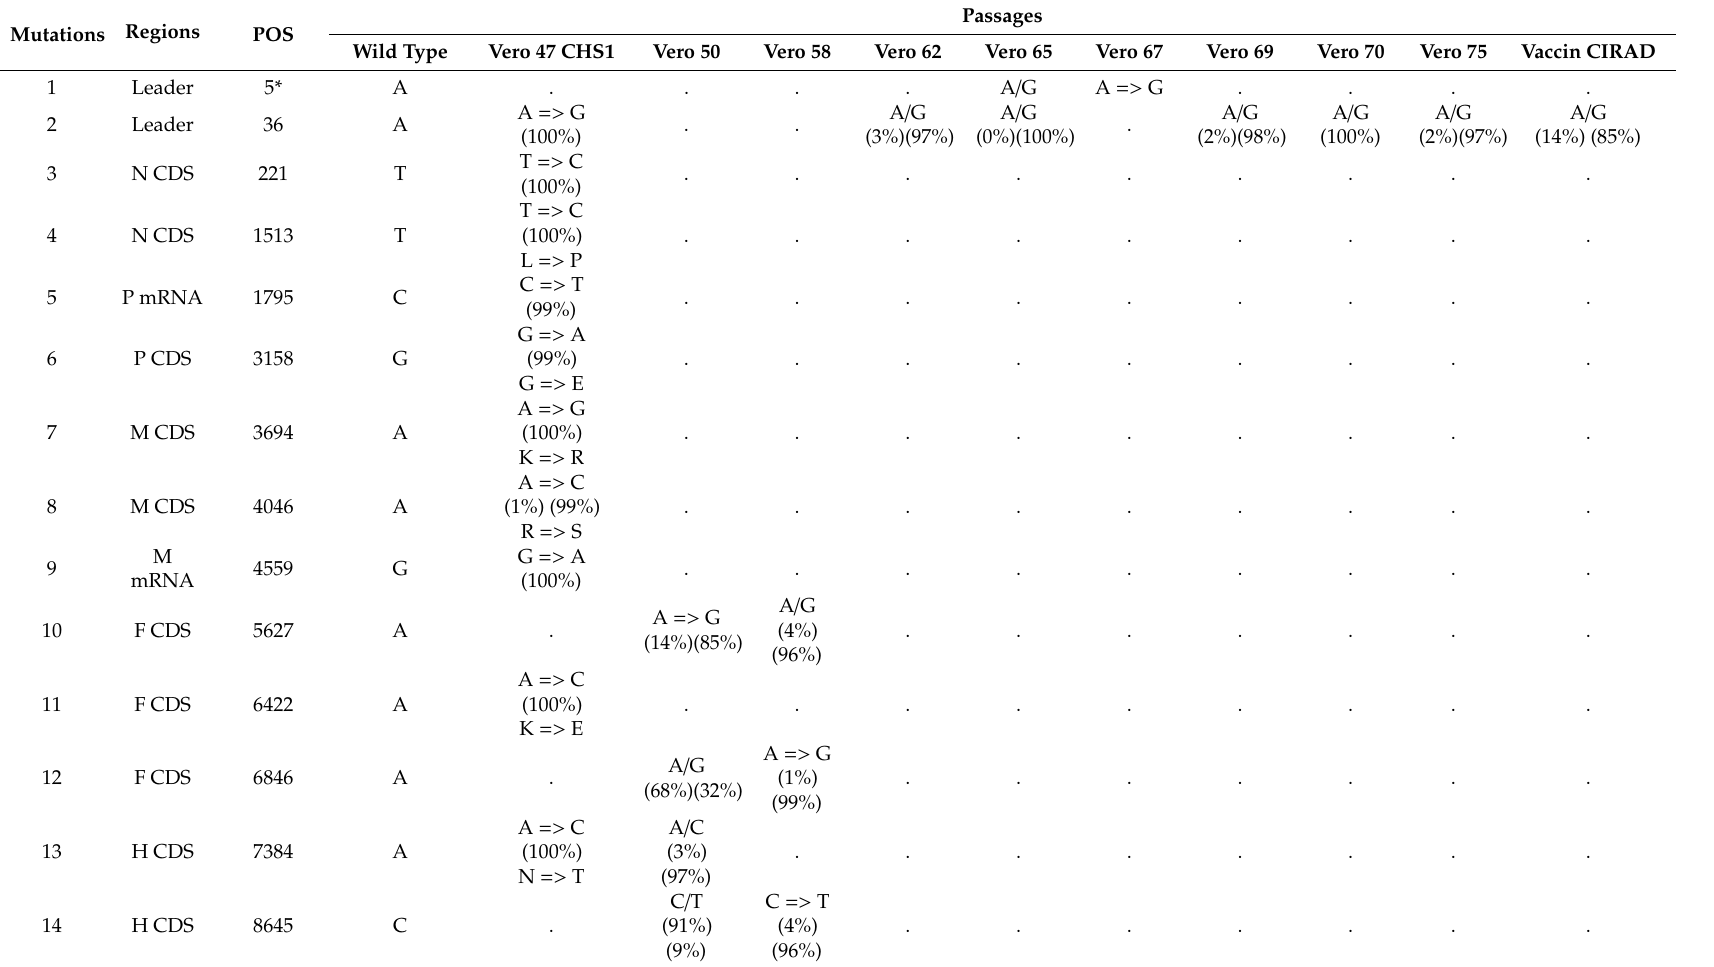
Table 1. Evolution of the mutations that led to mitigation of the vaccine strain before the vaccine was obtained. Mutations